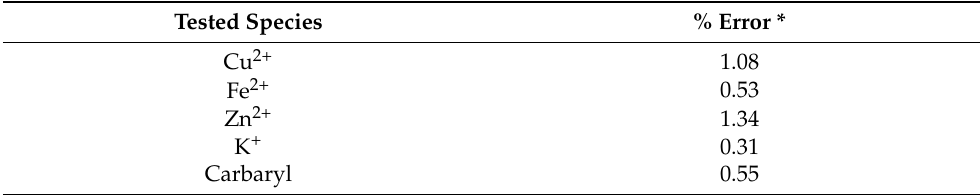
Table 1. Effect of foreign species.